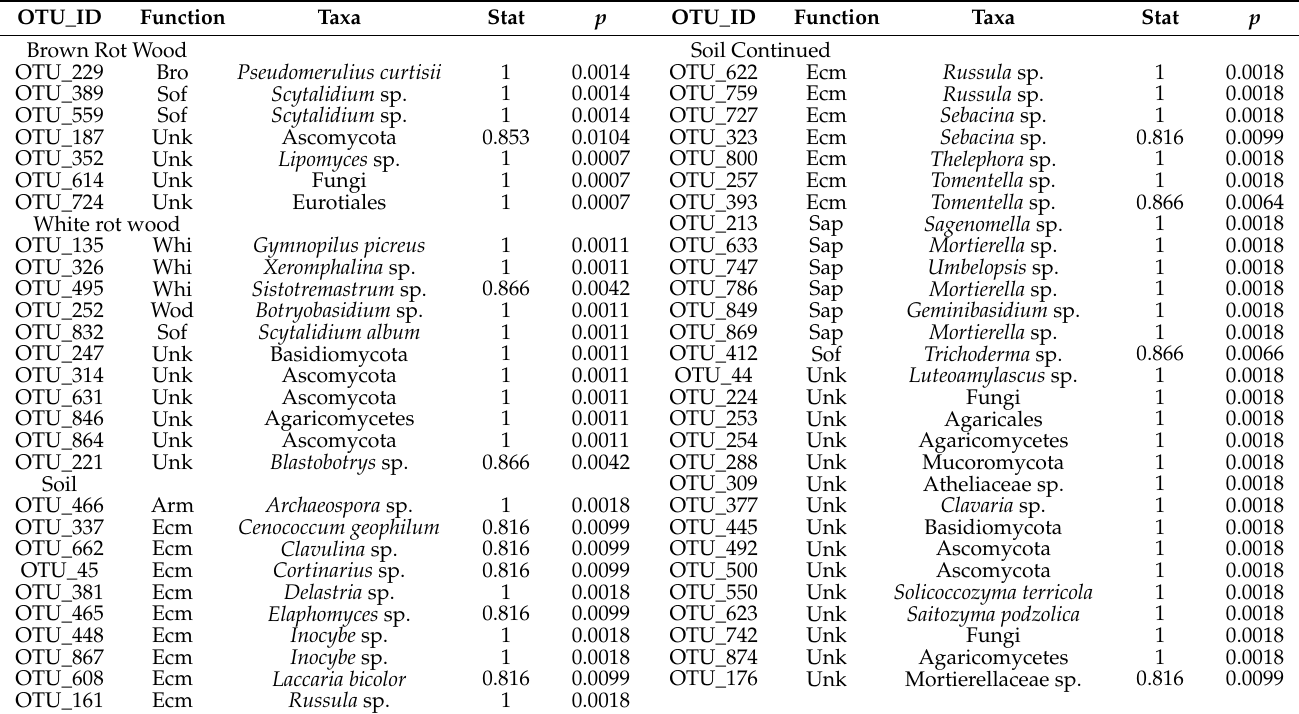
Table 3. Results of indicator species analysis for brown rot wood, white rot wood, and soil. OTUs with p < 0.01 were shown. See footnote in Table 1 for abbreviations of function.